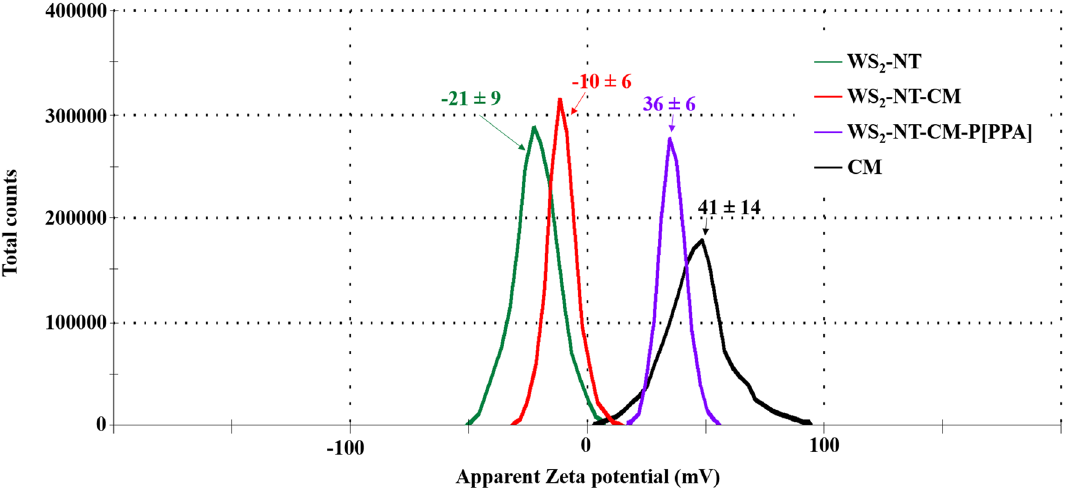
Figure 6. Zeta potential values and distribution curves of WS 2 -NT (green), WS 2 -NT-CM (red), WS 2 -NT- CM-P[PPA] (purple), and CM NPs (black). For each type of composite/particle, three measurements were performed, and values present the average result and the standard deviation.